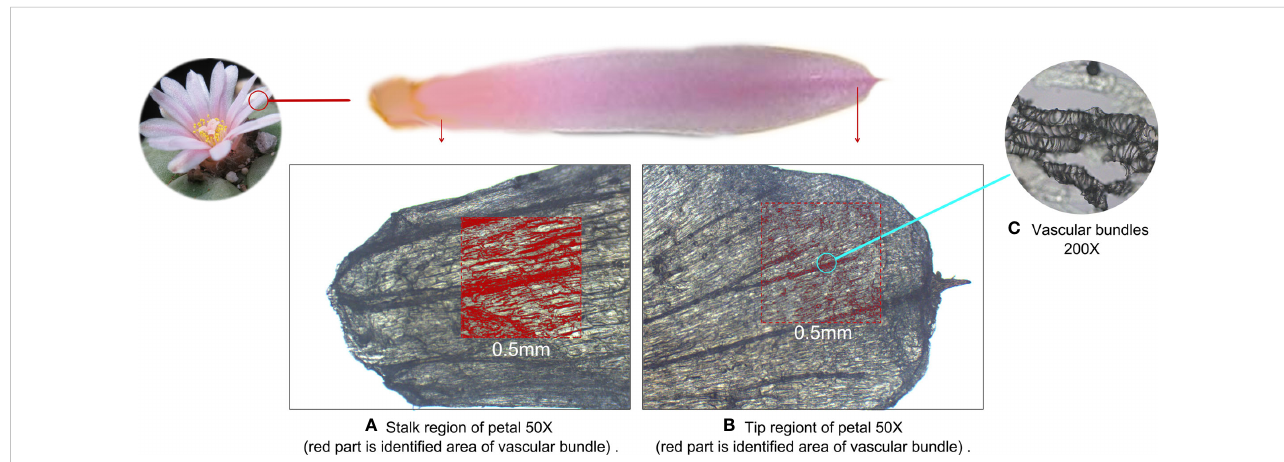
FIGURE 6 Microscopic optical image of the petal of Lophophora williamsii , with the red area de fi ned as vascular bundles. (A) Stalk region of the petal. (B) Tip region of the petal. (C) Vascular bundles